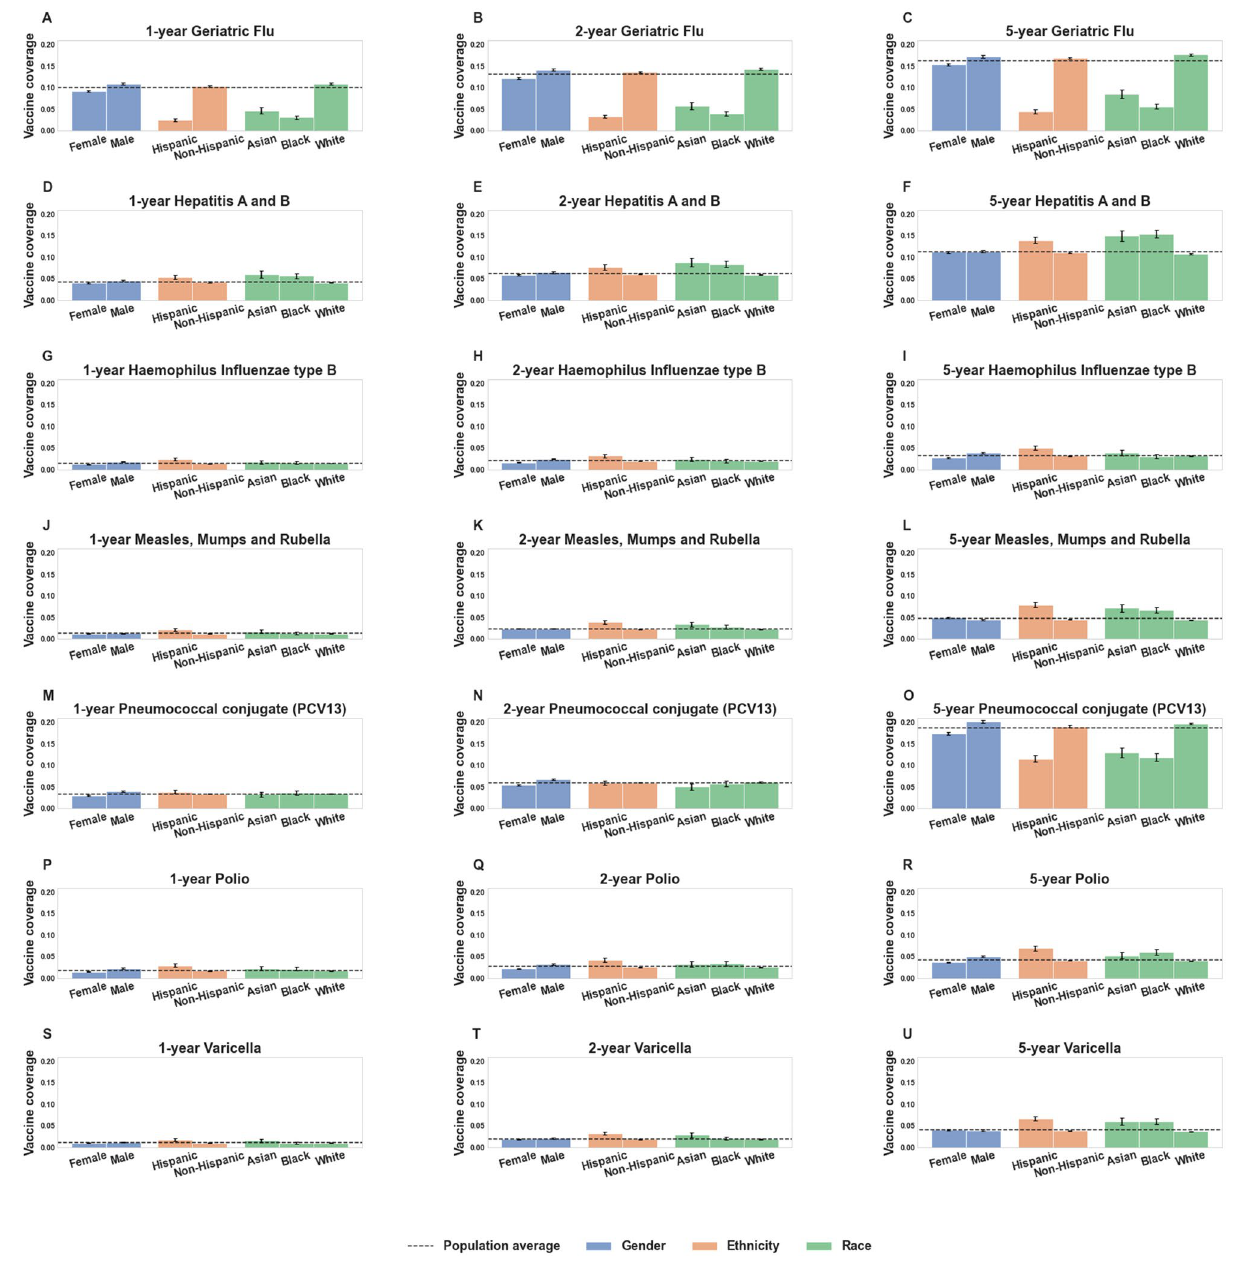
Figure 3. Vaccination coverage plots. Coverage rates for vaccines associated with lower SARS-CoV-2 rates, stratified by different demographic factors (age, race/ethnicity, and gender), along with 95% confidence intervals. In each plot, the population average vaccination rate for the (vaccine, time horizon) pair is shown as a horizontal line. Includes coverage rates for the following vaccines for the past 1, 2, and 5 year time horizons : ( A – C ) Geriatric Flu vaccine, ( D – F ) Hepatitis A / Hepatitis B (HepA-HepB), ( G – I ) Haemophilus Influenzae type B (HIB), ( J – L ) Measles-Mumps-Rubella (MMR), ( M – O ) Pneumococcal Conjugate (PCV13), ( P – R ) Polio, ( S – U )